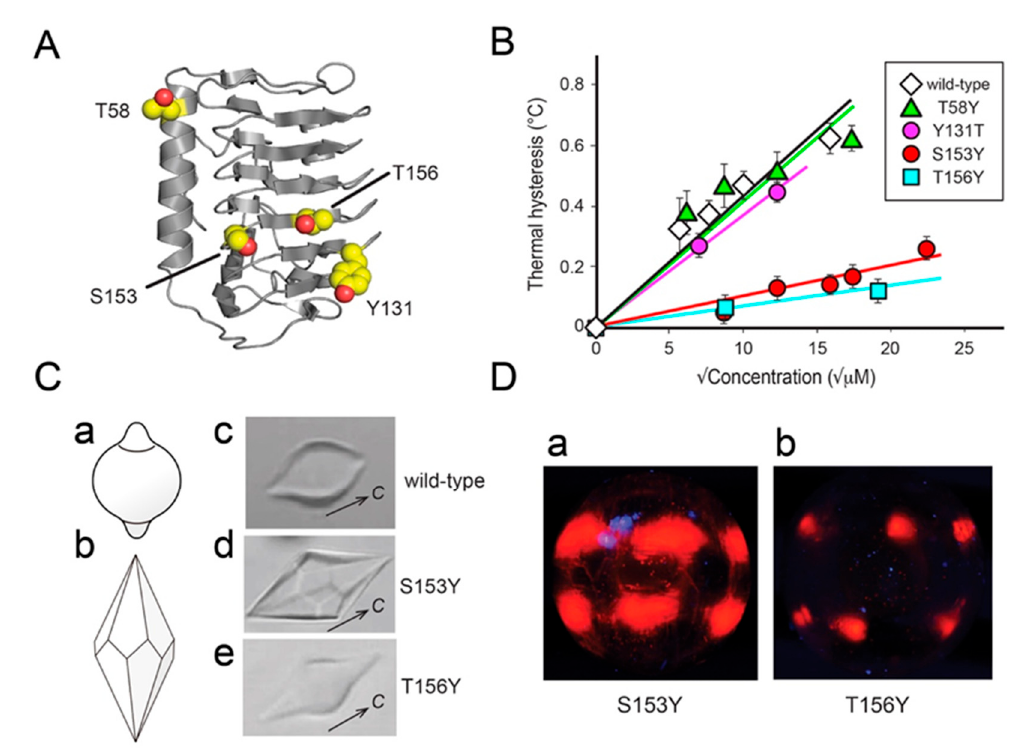
Figure 3. Effect of amino acid replacement on the ice-binding ability of Anp IBP. ( A ) Mutation sites on the crystal structure of Anp IBP. The side chains of the wild-type residues are shown as spheres. T58 is located on the A-face and the others on the B-face. ( B ) Thermal hysteresis activities (°C) of Anp IBP and its mutants plotted against the square root of each concentration. ( C ) Morphologies of a single ice crystal observed for Anp IBP and its mutant solutions. Illustrations show a lemon-shape ice crystal (a) observed for hyperactive IBPs and a bipyramidal ice crystal (b) observed for moderately active IBPs. The wild-type Anp IBP showed a lemon-shaped ice crystal (c), whereas the defective mutants (S153Y and T156Y) showed crystal bipyramids (d and e). ( D ) Comparison of FIPA patterns between the S153Y and T156Y mutants of Anp IBP. The orientation of these ice crystal hemispheres are the same as in Figure 1B,D. These mutants lost the ability to bind to the prism ring.